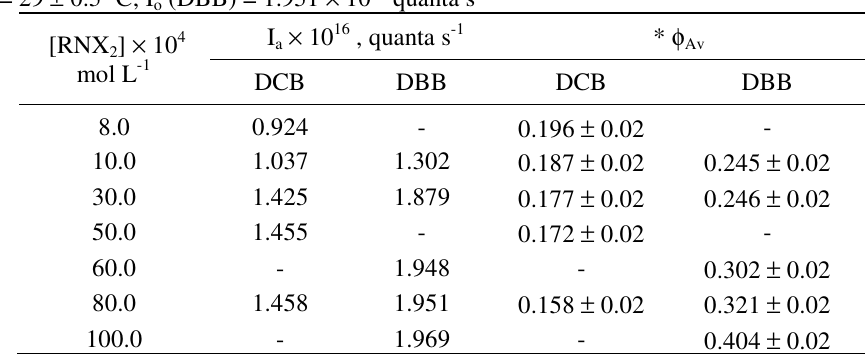
Table 4. Average quantum yield ( f Av ) for photolysis of DCB and DBB in aqueous acetic acid